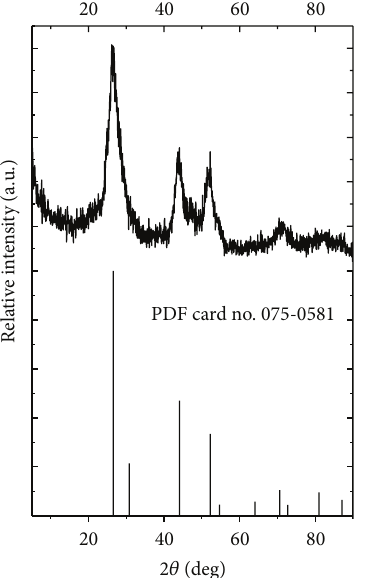
Figure 1: The XRD pattern of ( CdS ) 𝑛 .